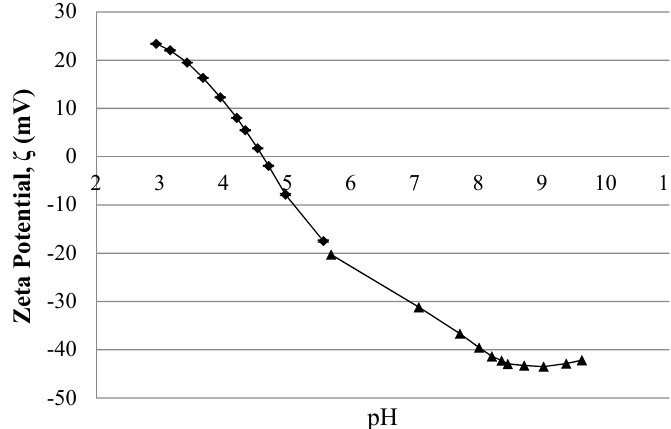
Figure 2. Graph of zeta potential of Membrane A as a function of pH.